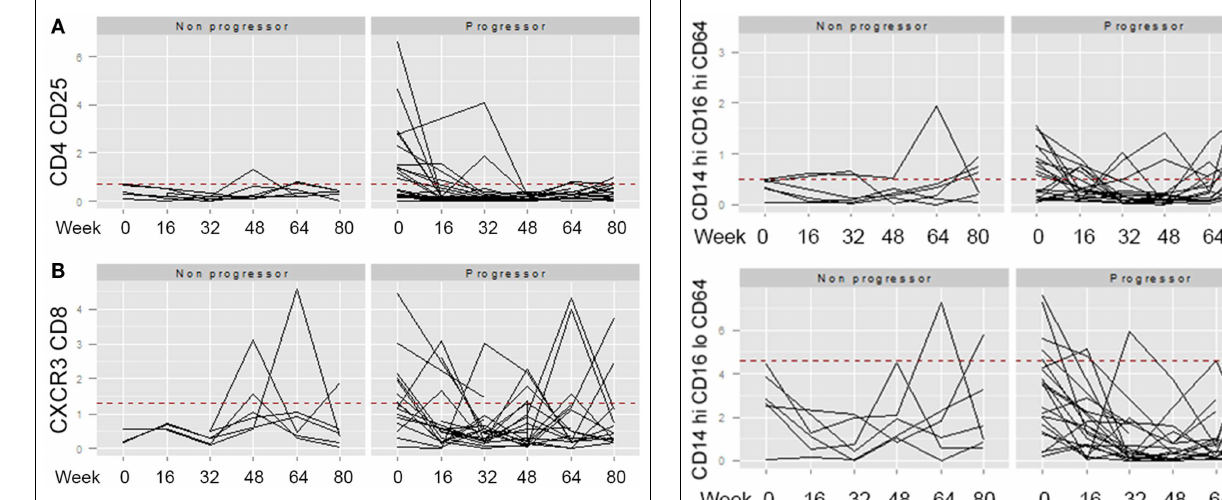
FIGURE 5 | Longitudinal analyses of monocyte phenotypes are highly variable .The percentage of CD14hi CD16hi CD64 (top) or CD14hi CD16lo CD64 (bottom) expressing monocytes identified at longitudinal time points (weeks 0, 16, 32, 46, 64, and 80) were graphed.The dotted red line indicates the threshold above which this cell population was found to predict the patient reaching the combined endpoint in Table 5